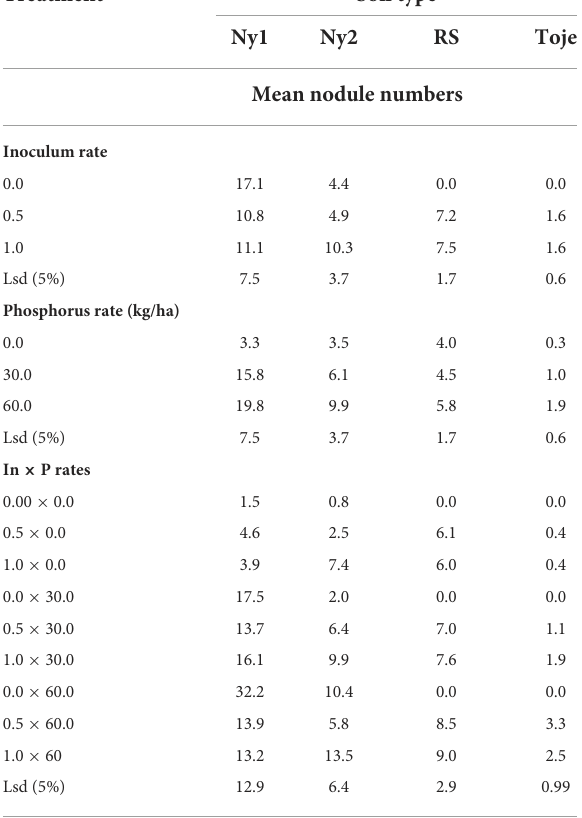
TABLE 3 Effect of varying rates of Histick Soy and P on nodule numbers *